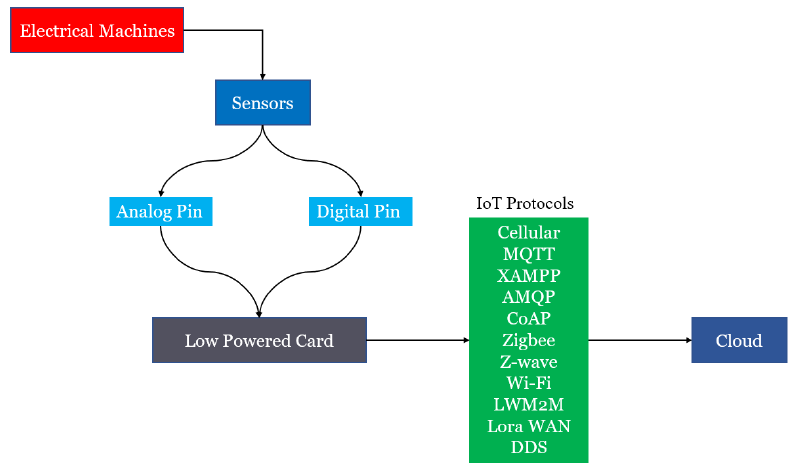
Figure 1. The schematic diagram of data acquisition and transmission to the cloud using IoT.